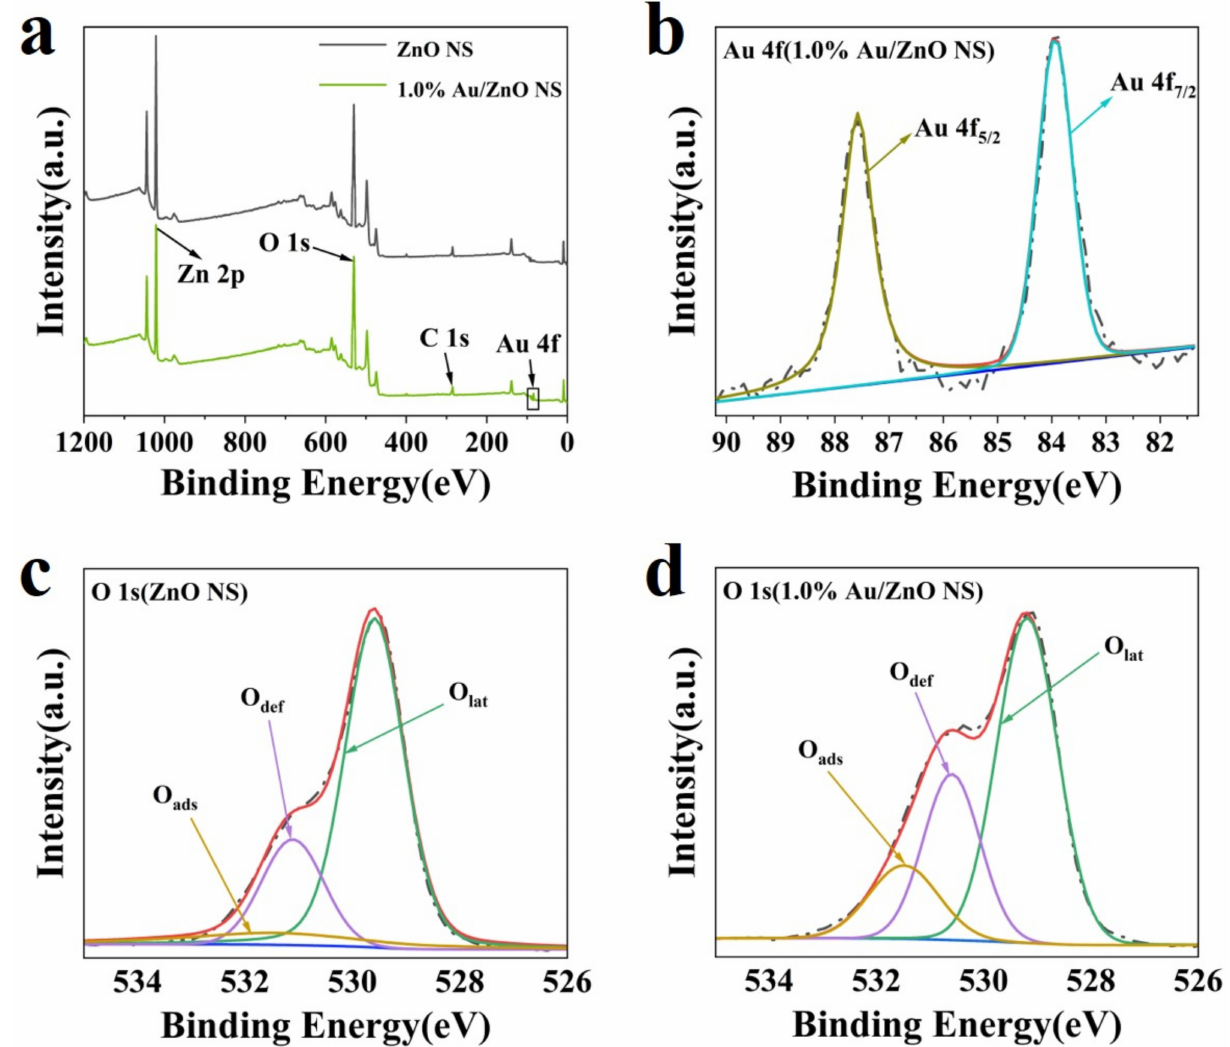
Figure 4. ( a ) Full XPS spectrum of ZnO NS and 1.0% Au/ZnO NS. ( b ) High-resolution Au 4f XPS spectra of 1.0% Au/ZnO NS. ( c , d ) High-resolution O 1s XPS spectra of ZnO NS and 1.0% Au/ZnO